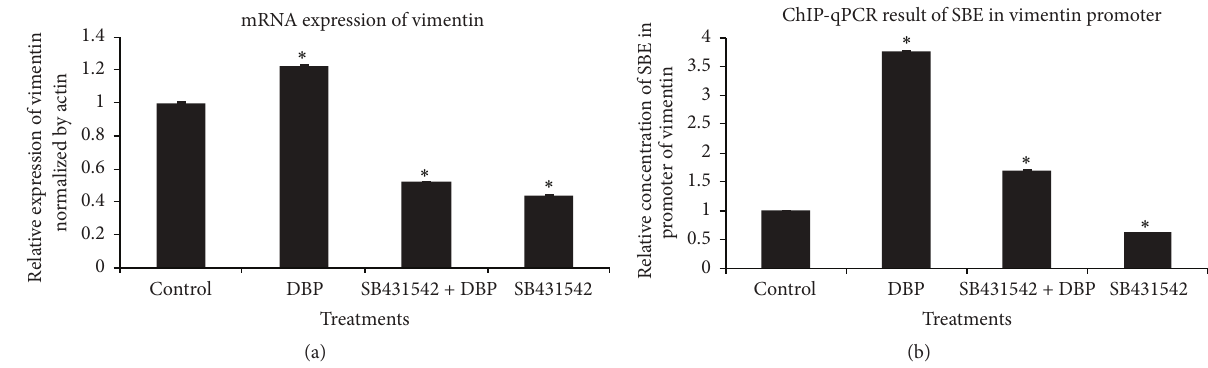
Figure 1: Real-time PCR of vimentin and ChIP-qPCR of Smad binding element (SBE) in the promoter region of vimentin in control and DBP-, SB431542 + DBP-, and SB431542-treated SCs at 24 h. (a) Real-time PCR of vimentin in the indicated SCs. (b) ChIP-qPCR of SBE in the vimentin promoter in the indicated SCs. 𝑃 < 0.05 was considered statistically